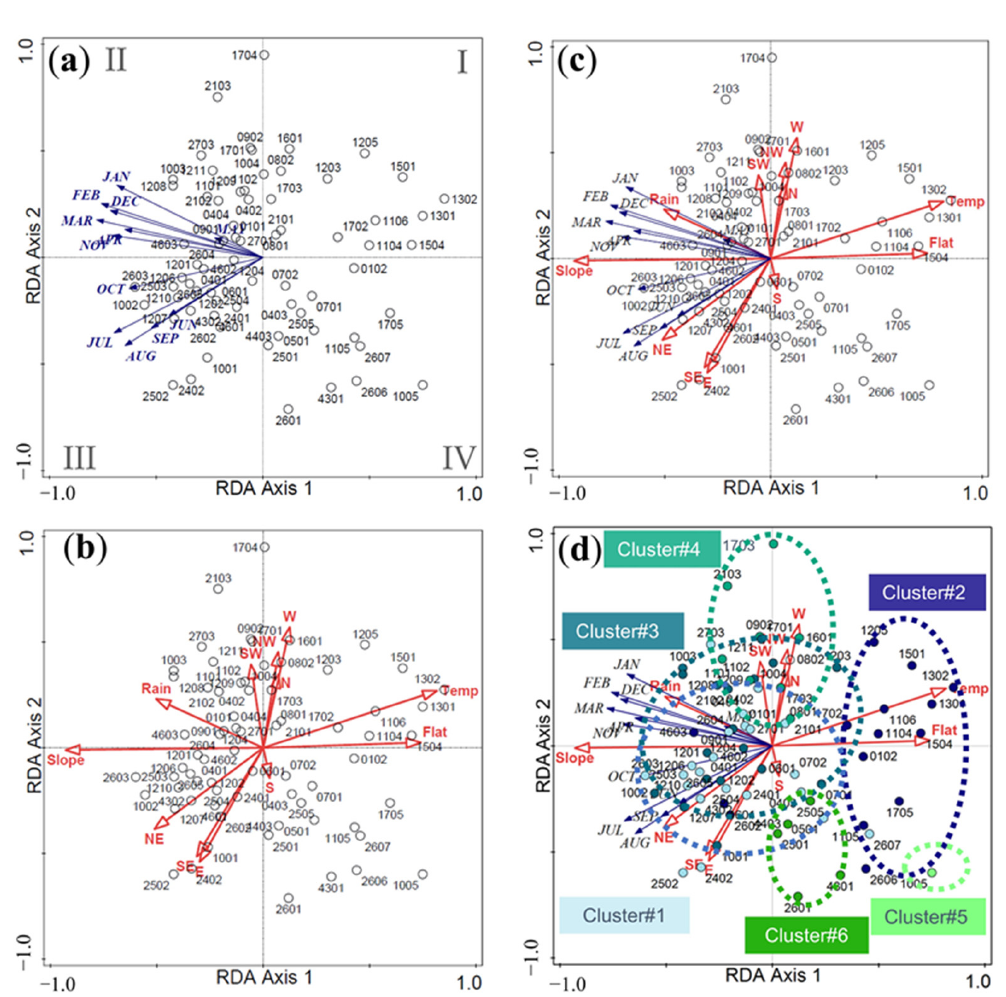
Figure 3. RDA results with the quadrants numbering in an anti-clockwise direction starting from the upper-right corner. ( a ) RDA biplot showing NDVI and watersheds; ( b ) RDA biplot showing explanatory variables with watersheds; ( c ) RDA triplot showing NDVI, explanatory variables, and watersheds; ( d ) HCA clusters incorporate with RDA triplot (dotted circles denote the HCA clusters). The cases circles denote watersheds while the blue and red arrows represent NDVI (RVs) and explanatory variables (EVs), respectively.